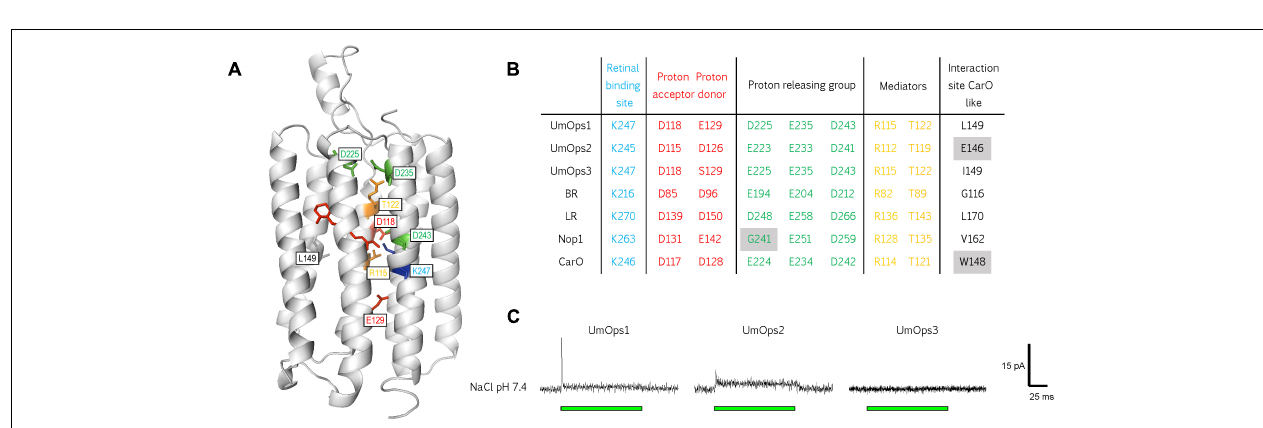
FIGURE 2 | Structural conservation and physiological function of the three U. maydis rhodopsins. (A) Model of UmOps1 based on the crystal structure of the Acetabularia rhodopsin I with resolution of 1.57 Å (5awz.1) (Furuse et al., 2015). (B) Prominent residues that are well conserved in microbial rhodopsins of BR, LR, Nop1, CarO, and the three U. maydis rhodopsins. The respective position of the amino acids in the rhodopsin entity is given exemplary for UmOps1 in A. The well-conserved proton donor corresponding to Asp-96 in bacteriorhodopsin is replaced by a glutamate in UmOps1 and a serine in UmOps3. (C) Whole-cell patch-clamp analysis of the rhodopsins that were heterologously expressed in HEK293 cells. A 532 nm laser (green bar) was used for excitation. While UmOps1 and UmOps2 are green light-activated ion pumps, no light-dependent signal was observed for UmOps3.